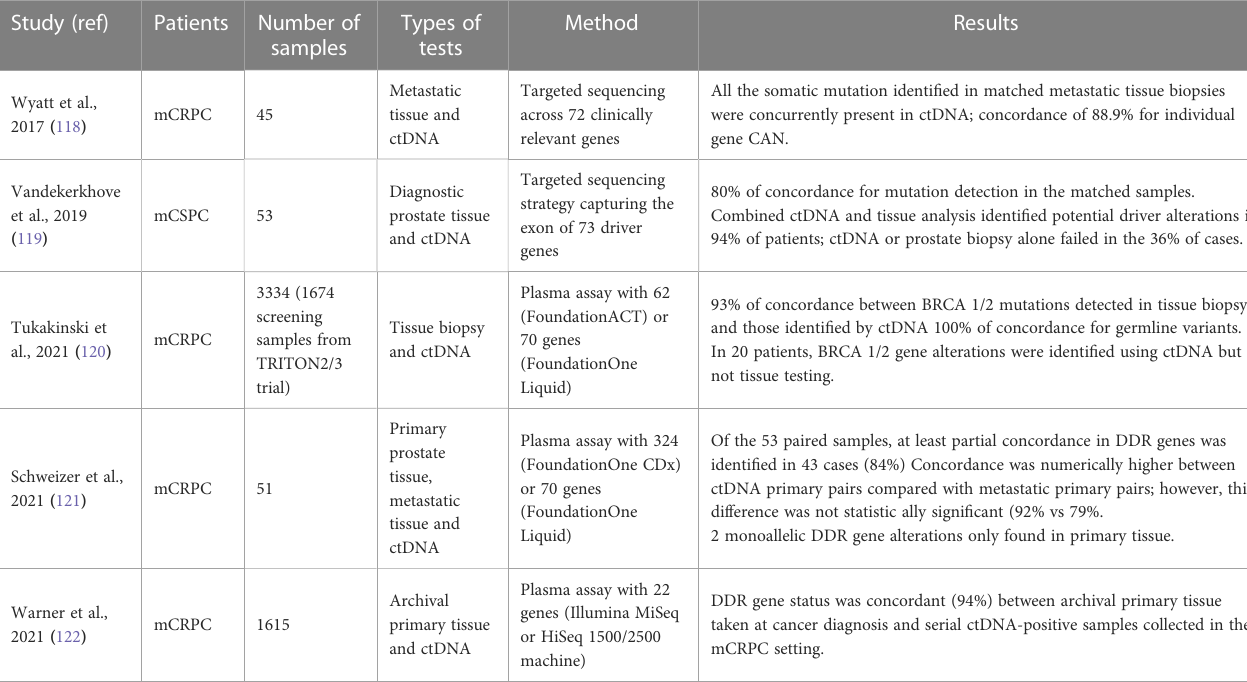
TABLE 2 Summary of the studies evaluating concordance between tissue and cDNA testing. Study